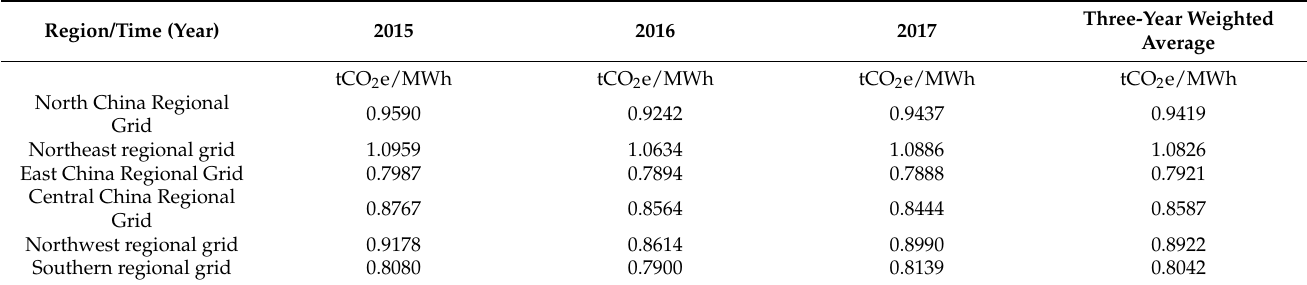
Table 3. Summary of calculation results of OM emissions factors for six regional grids in China in